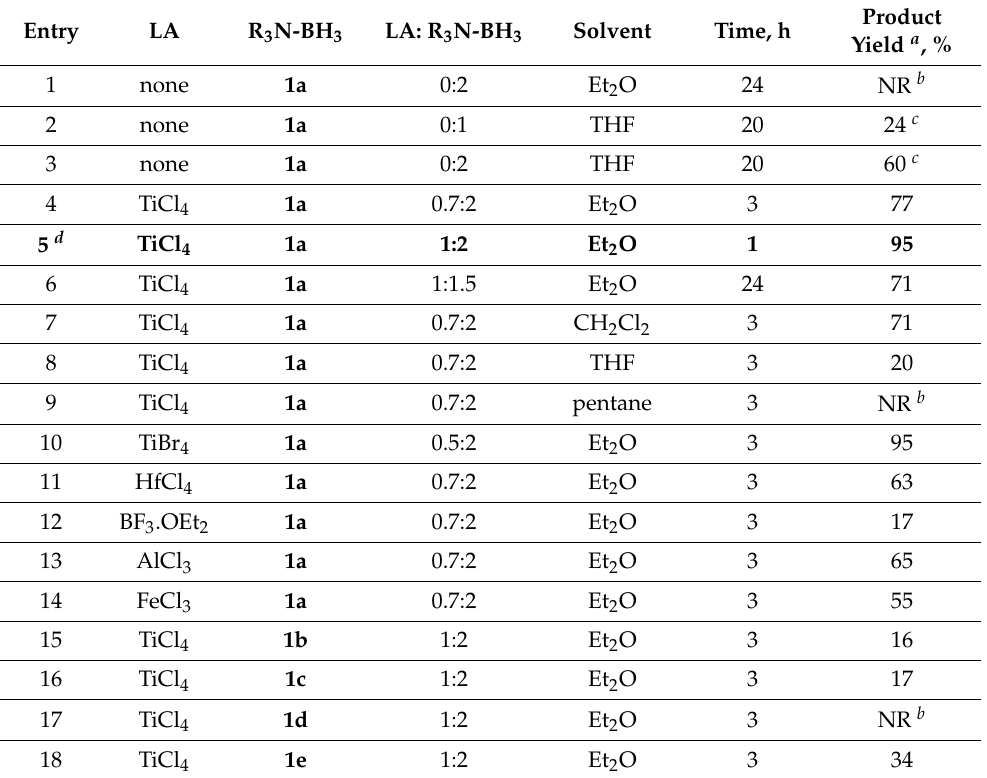
Table 1. Optimization of reaction conditions for the reduction of benzonitrile. Entry LA R 3 N-BH